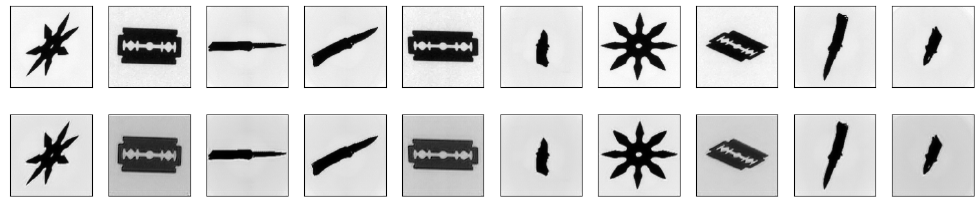
Figure 4. GDXary+